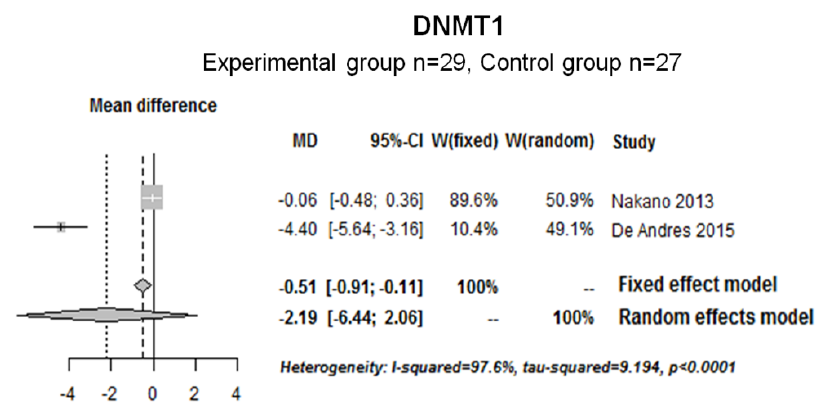
Figure 8. Forest plot for DNMT1 modified expression in human samples (T cell, SF).